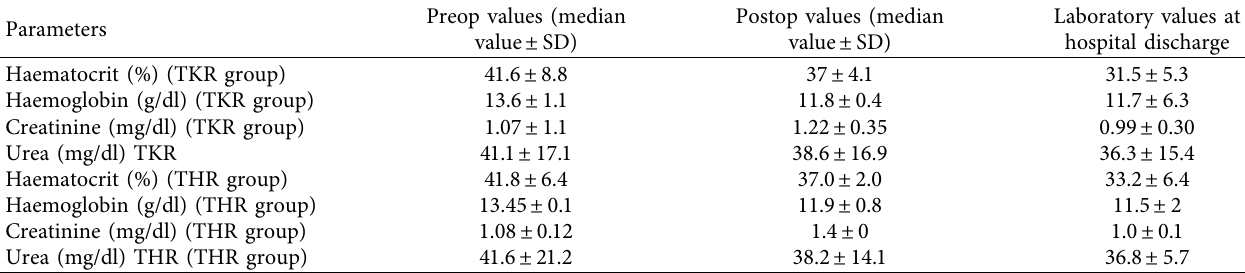
Table 3: Laboratory fndings at preoperative, postoperative, and hospital discharge periods among the TKR and THR groups.